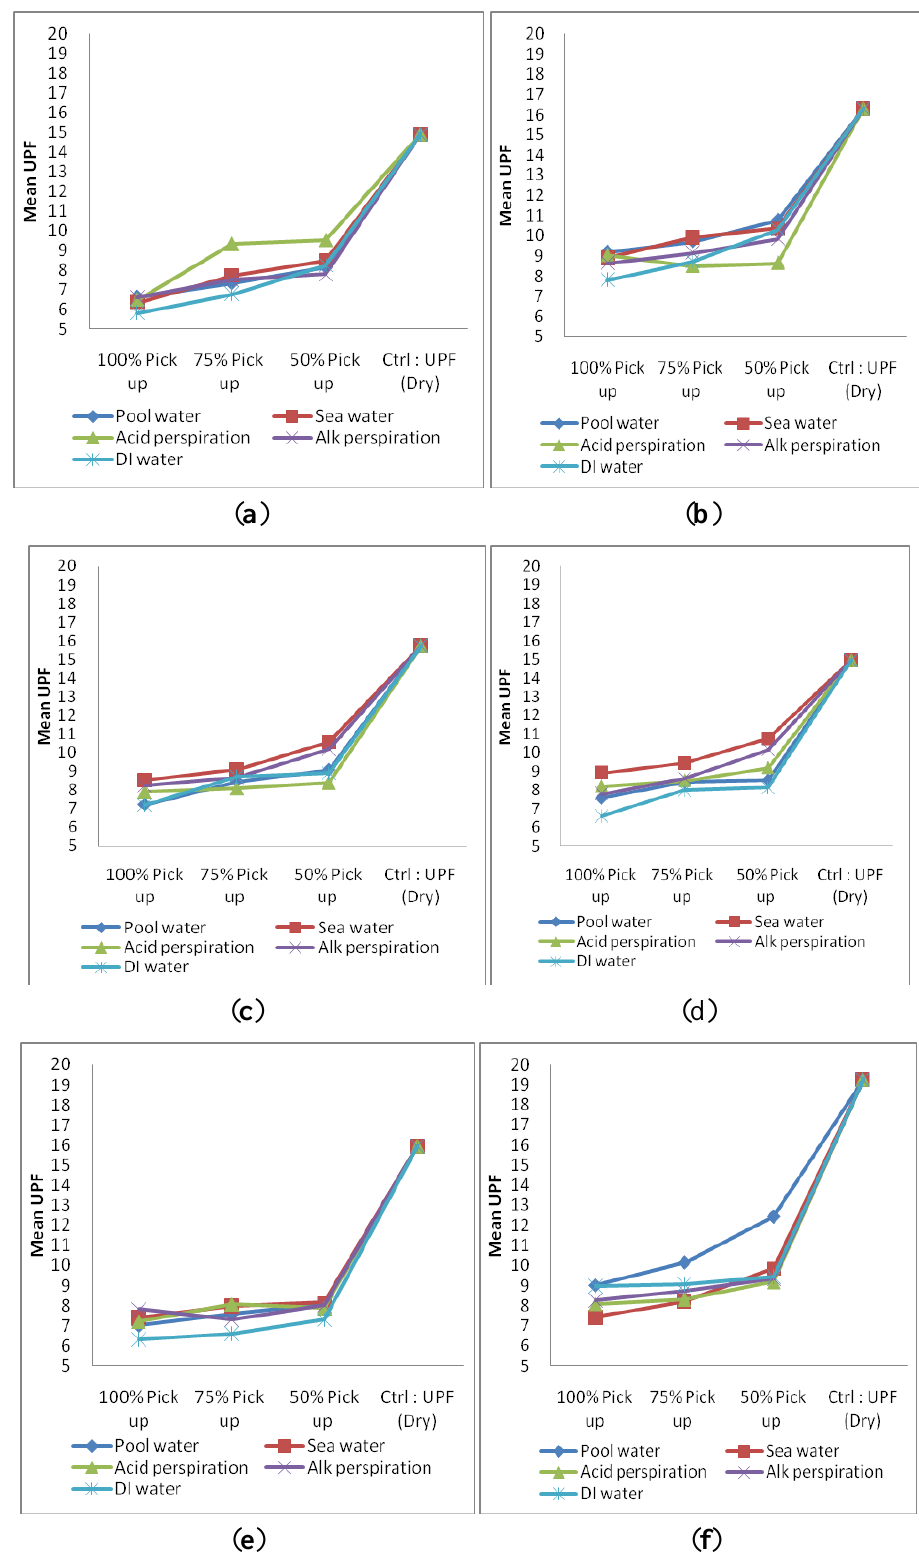
Figure 4. UPF of samples in Group II: ( a ) CH _ MCG; ( b ) CH _ F; ( c ) CH _ MF; ( d ) MCG _ F; ( e ) MCG _ MF and ( f ) F _ MF wetted with five types of solution at three different pick-up